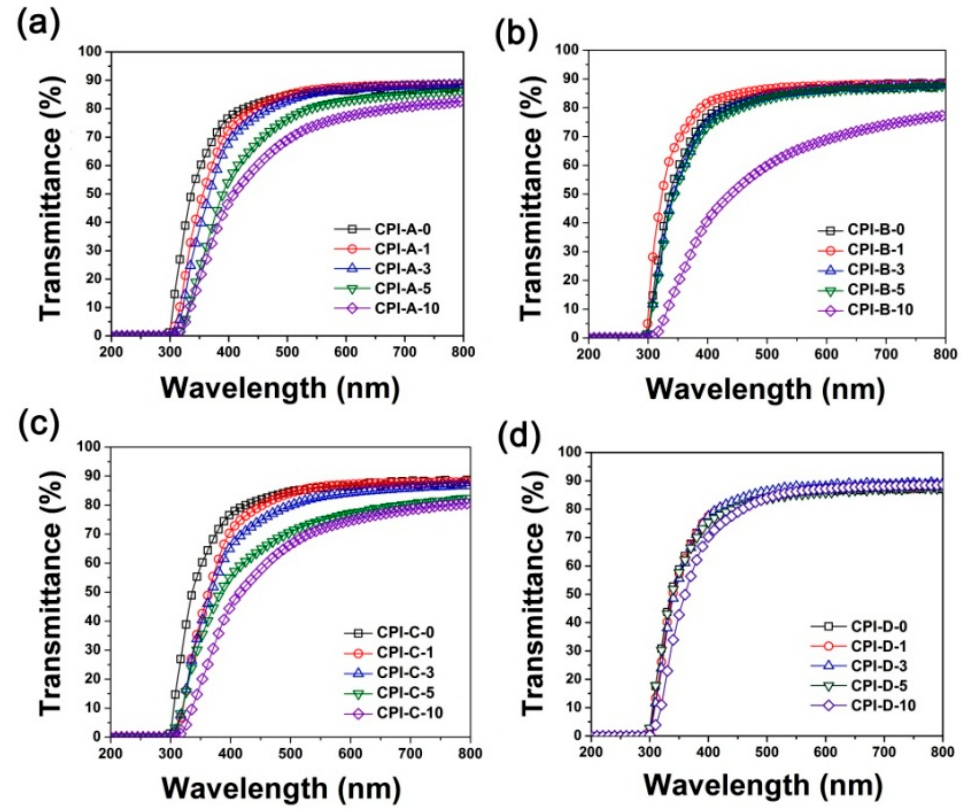
Figure 9. UV-Vis spectra of CPI/HALS nanocomposite films. ( a ) CPI-A; ( b ) CPI-B; ( c ) CPI-C; ( d ) CPI-D.